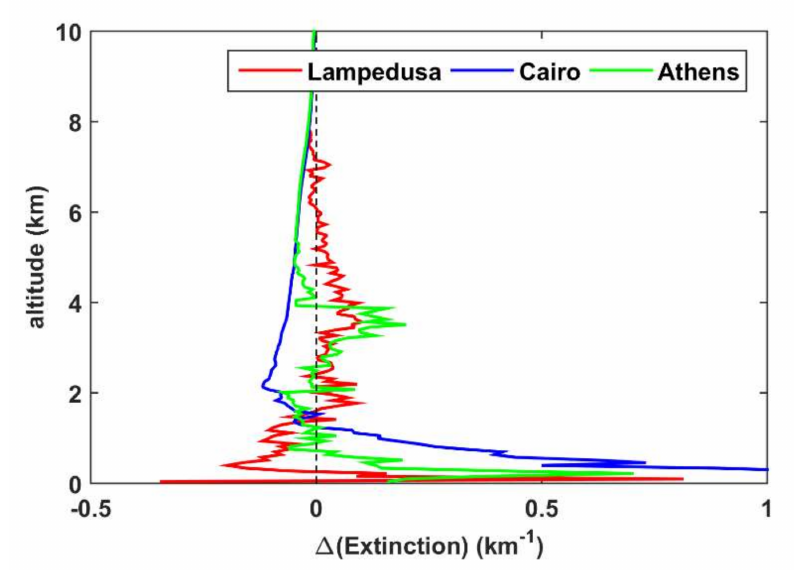
Figure 13. Differences between the 532 nm LIVAS and the libRadtran default extinction coefficient profiles. The profiles have been scaled to AOD = 1 to calculate the differences. The LIVAS profile for each of the three sites is the average of all profiles corresponding to AOD at 532 nm larger than 0.8 for the period 2006–2018.